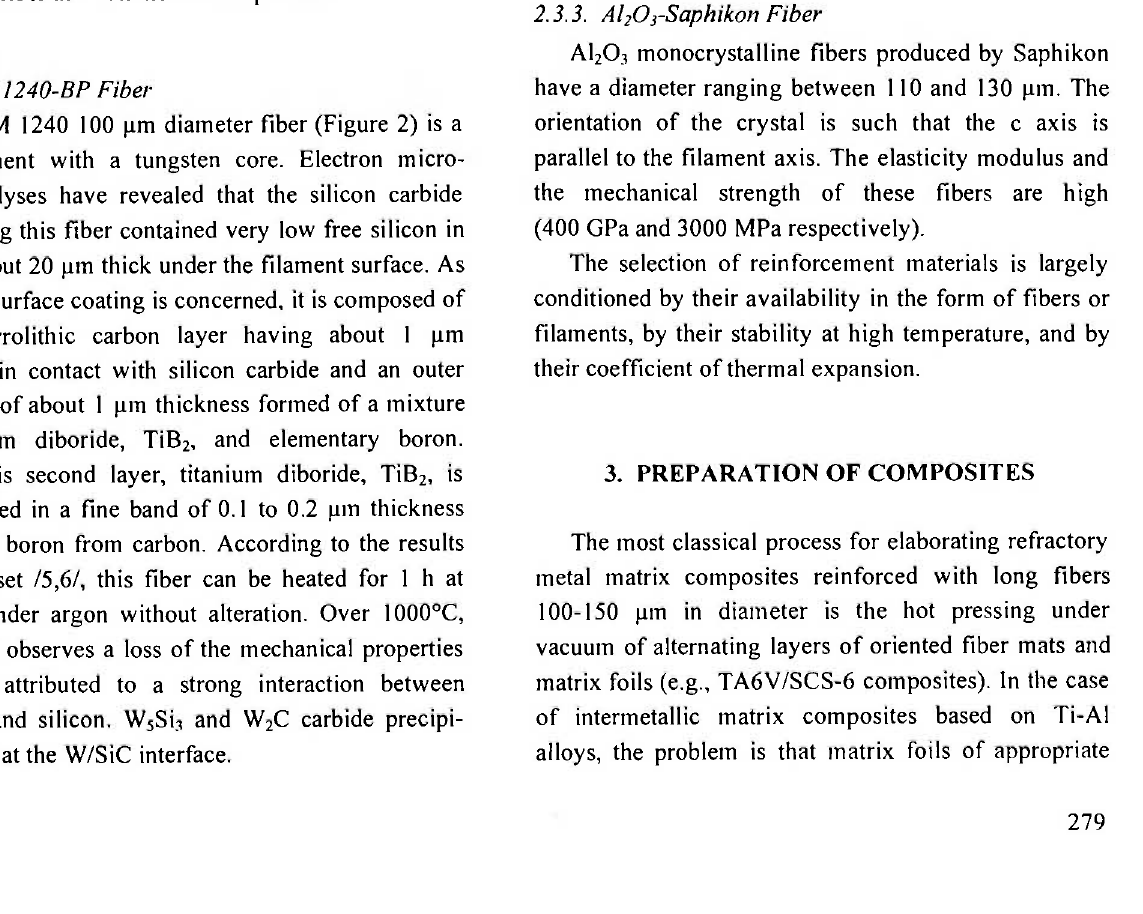
Fig. le: Evolution of mechanical strength of SCS-6 fiber as a function of temperature.